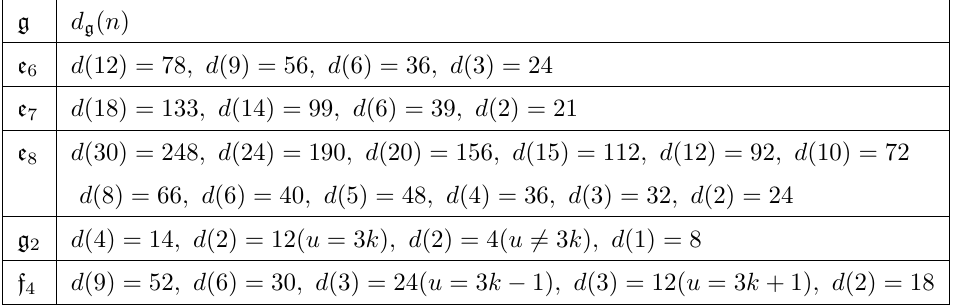
Table 17 . Data used to compute the growth function G of VOA W − h ∨ + n u ( g , f prin ) , where G = rank( g ) − d g ( n ) u